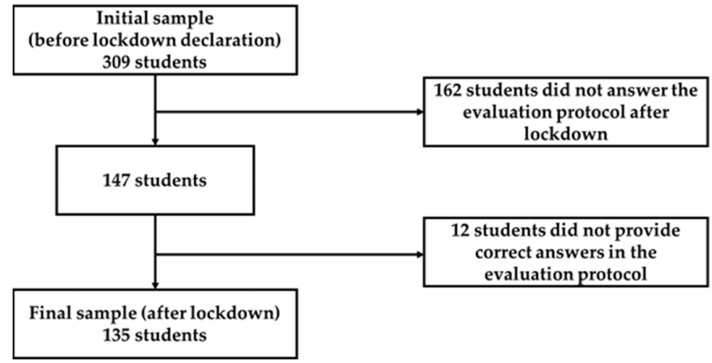
Figure 1. Flow-diagram of participant recruitment.